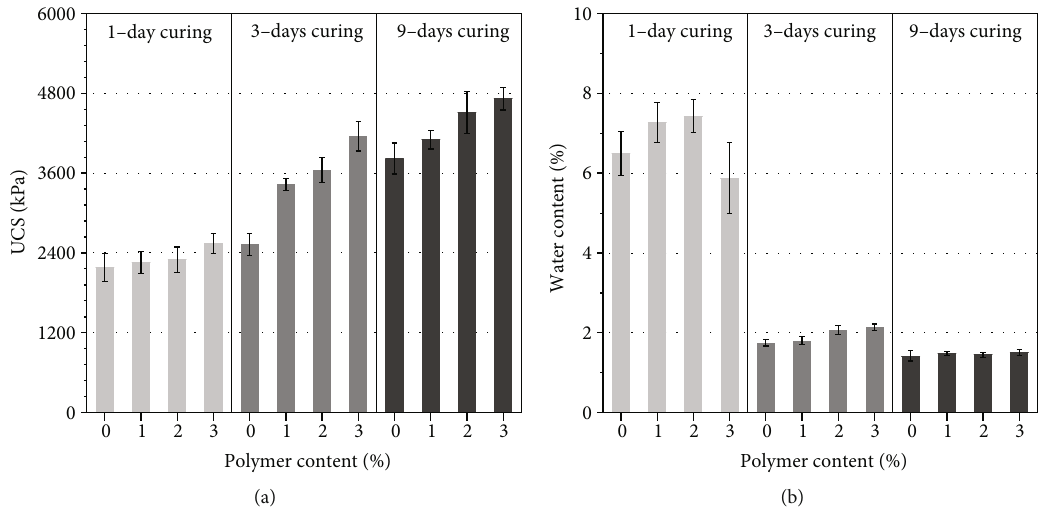
Figure 2: Results of the polymer treated specimens cured in room condition. Variations of (a) compressive strength and (b) water content of the specimens after 1, 3, and 9 days of curing. Results of the nontreated specimens are also plotted for comparison.